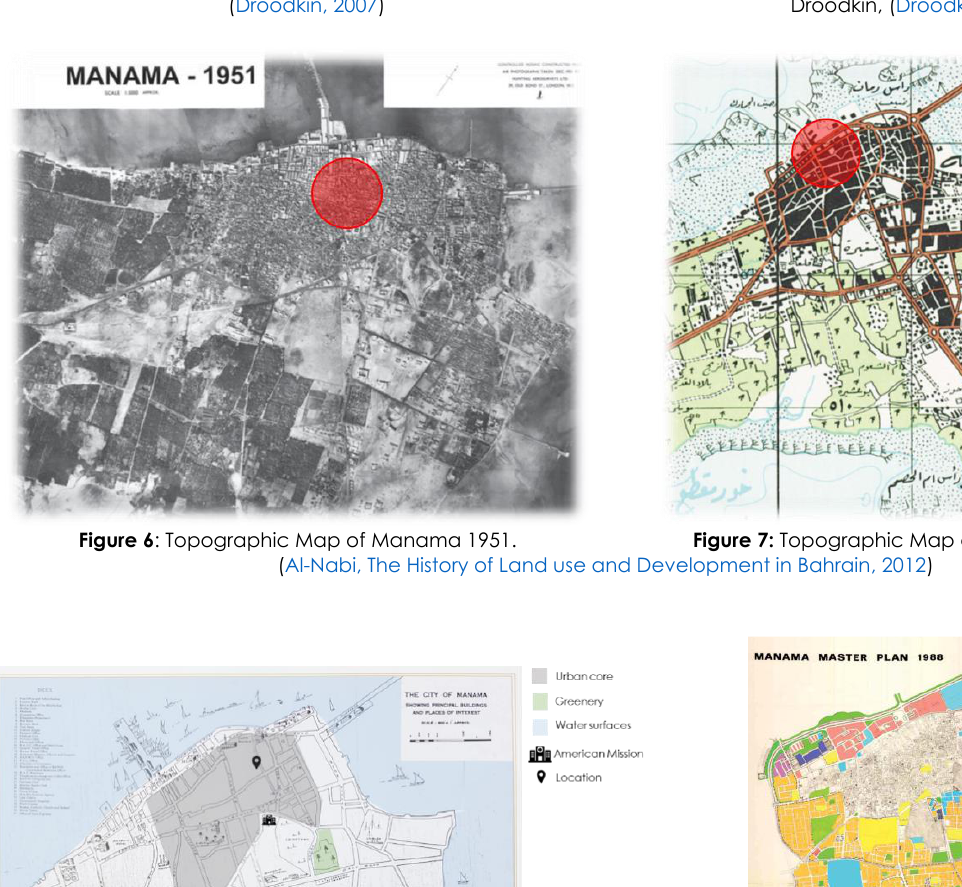
Figure 5: Ras Roman Residential district Droodkin, (Droodkin, 2007)